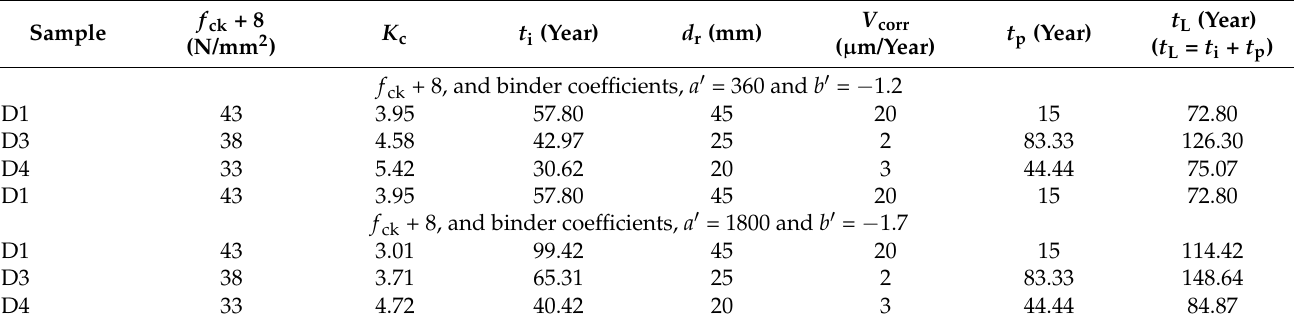
Table 8. Application of the carbonation model for the general calculation method for the useful life. Carbonation model according to EHE-08 data.